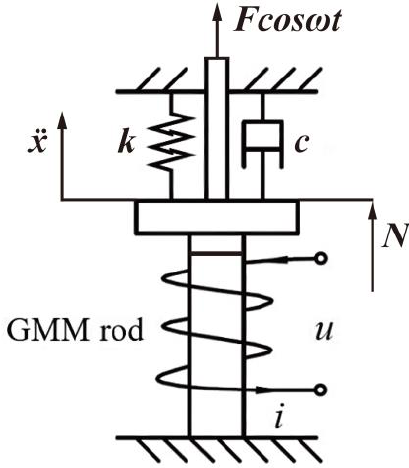
Figure 2. Simplified model of the GMA system.